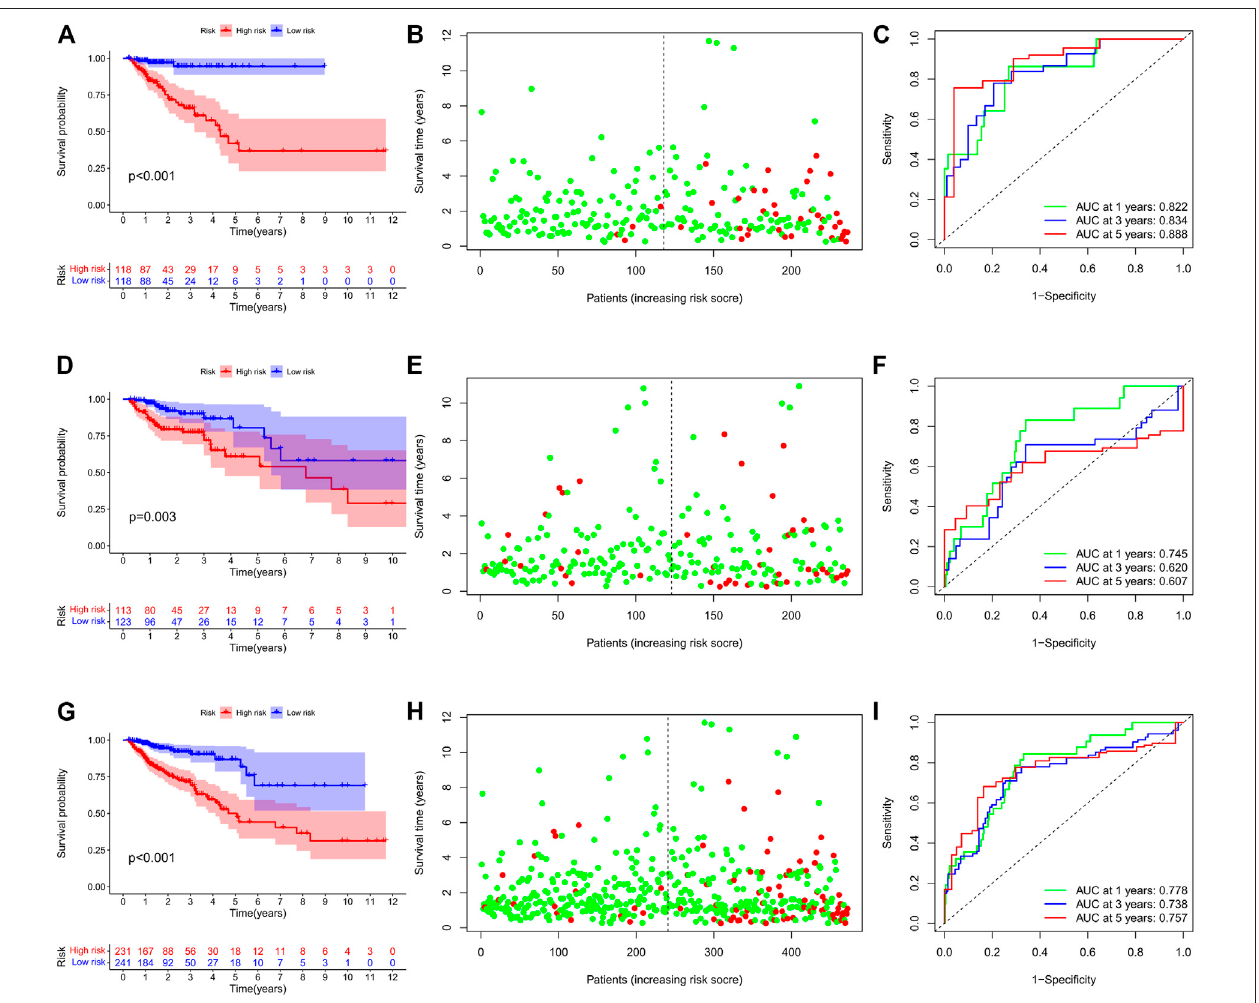
FIGURE 3 | Prognostic value of the IRG signature in human CRC. (A) Kaplan – Meier survival curve, (B) risk plot, and (C) ROC curve of the IRG signature in the trainingcohort. (D) Kaplan – Meiersurvivalcurve, (E) riskplot,and (F) ROCcurveoftheIRGsignatureintheinternalvalidationcohort. (G) Kaplan – Meiersurvivalcurve, (H) risk plot, and (I) ROC curve of the IRG signature in the entire TCGA cohort.